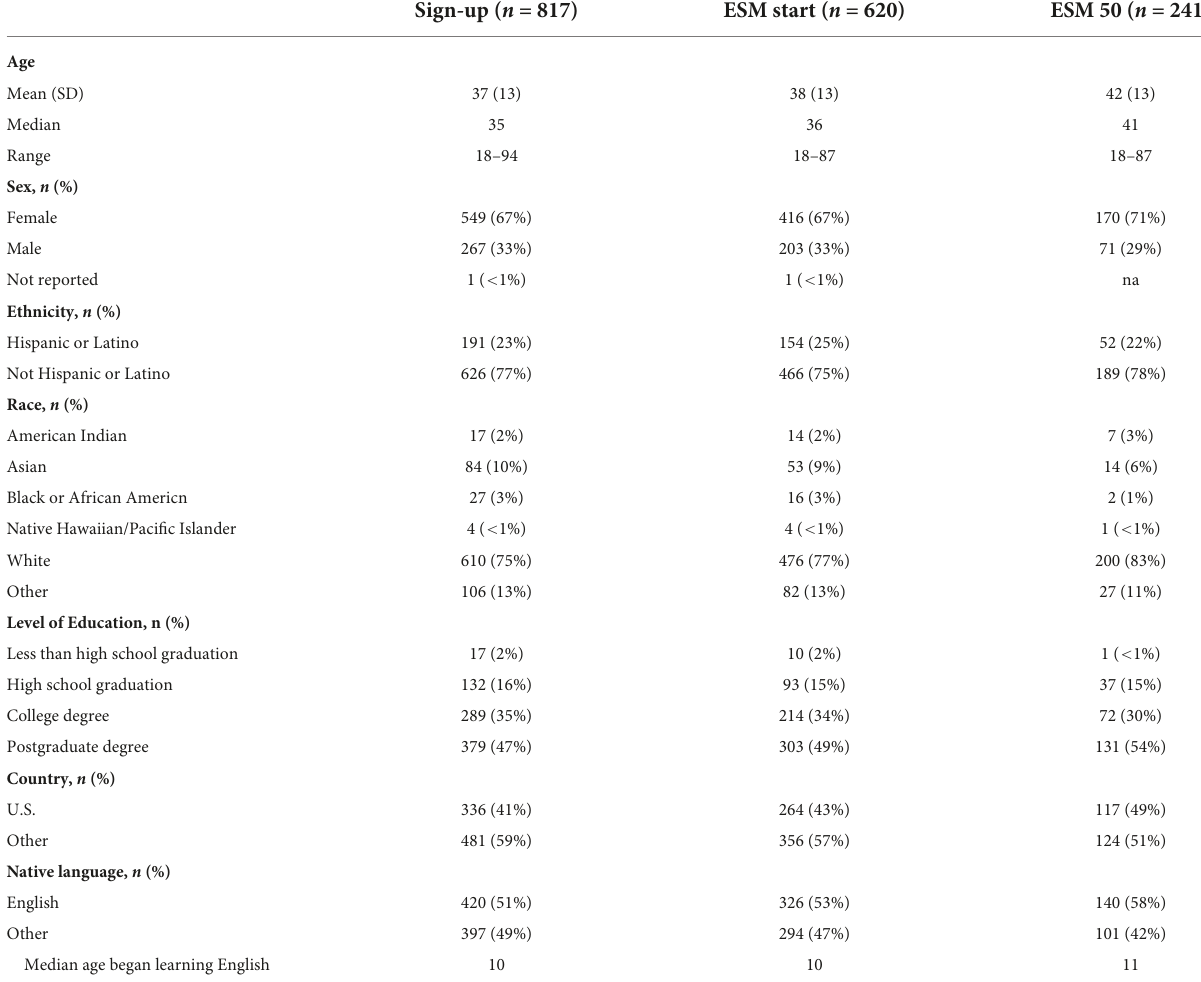
TABLE 2 Descriptive statistics for demographic